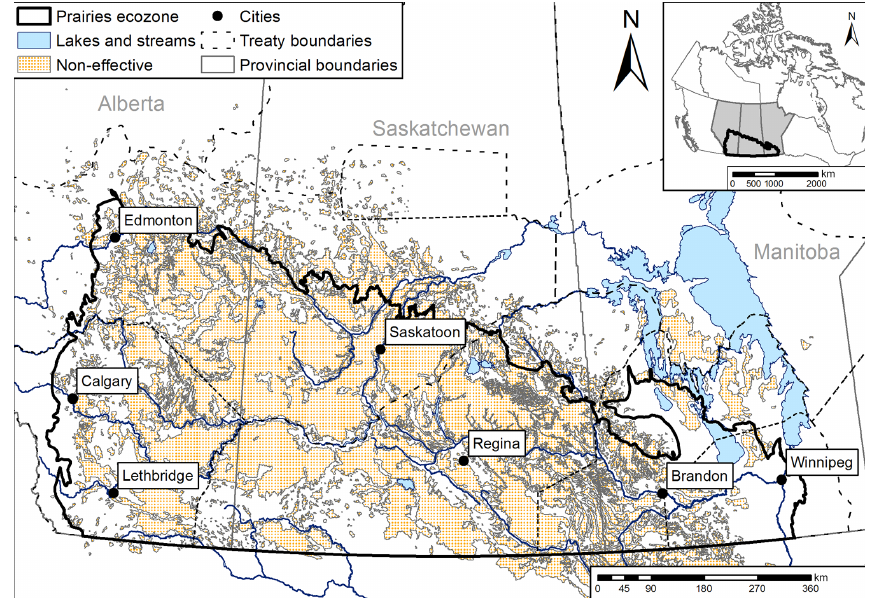
Figure 1. Map of the study area spanning the Prairie ecozone in western Canada (inset). Large cities in each of the three provinces are shown for reference, while the region characterized as not contributing runoff (2-year) is also shown. Prairie ecozone based on the region classified by the Ecological Stratification Working Group